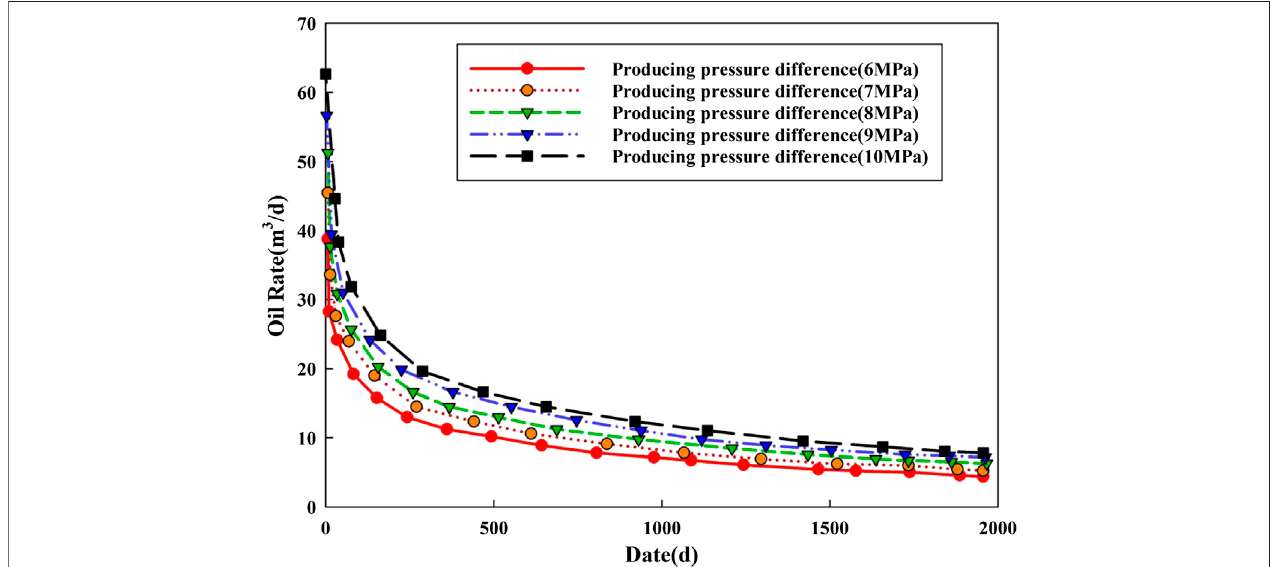
FIGURE 9 | Daily oil production curve of different producing pressure difference.